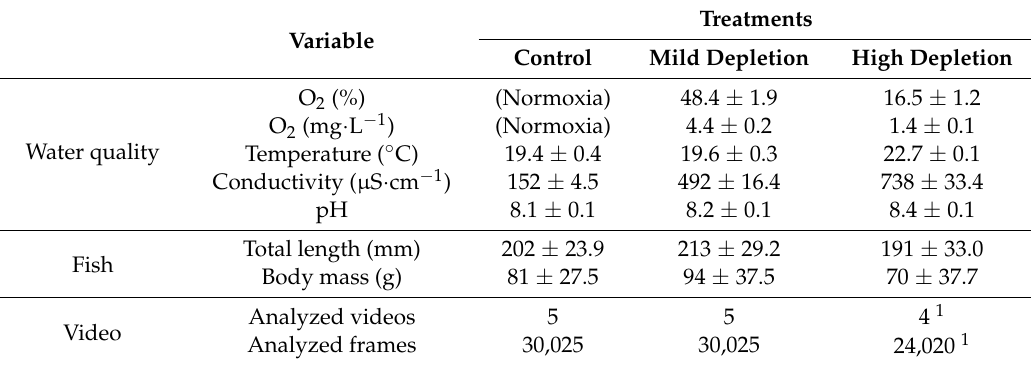
Table 1. Physiochemical and biological description of the experiments (average values ± SD), and number of analyzed videos and frames per